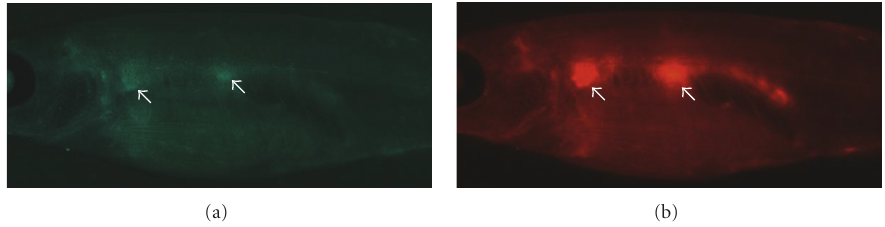
Figure 2: Direct visualization of engrafted GFP + and mCherry + marrow donor cells in casper recipients. 40 × 10 3 WKM cells from a transgenic ubiquitin:GFP donor were mixed with 80 × 10 3 WKM cells from a transgenic ubiquitin:mCherry donor and injected into the circulation of a casper recipient fish. The photos are taken 4 weeks after transplantation and show engraftment of (a) GFP + and (b) mCherry + cells in the kidney (white